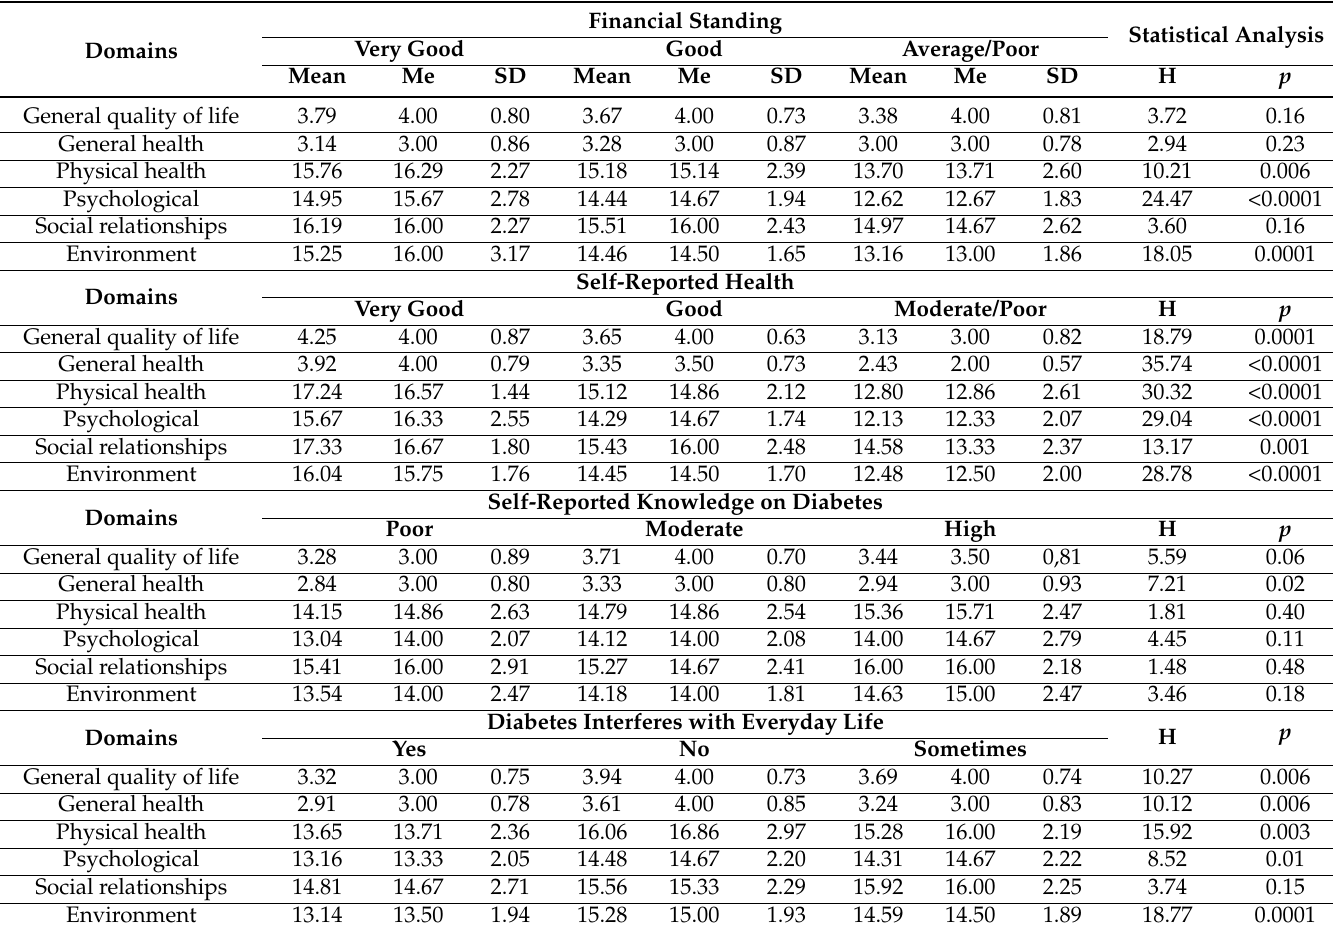
Table 4. Quality of life scores in relation to socio-demographic data and various aspects of life.